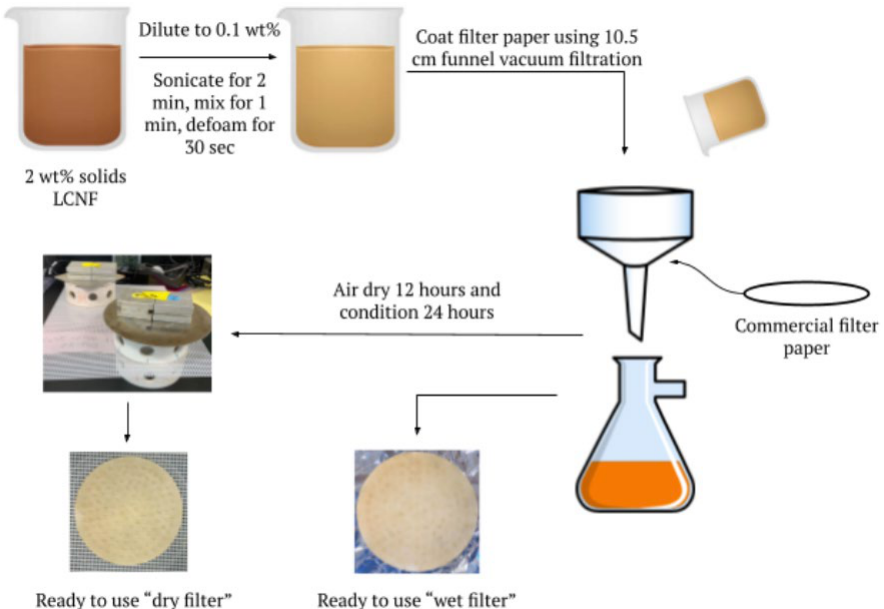
Figure 1. Summary of filter coating process of both wet and dry LCNF-modified filter papers.